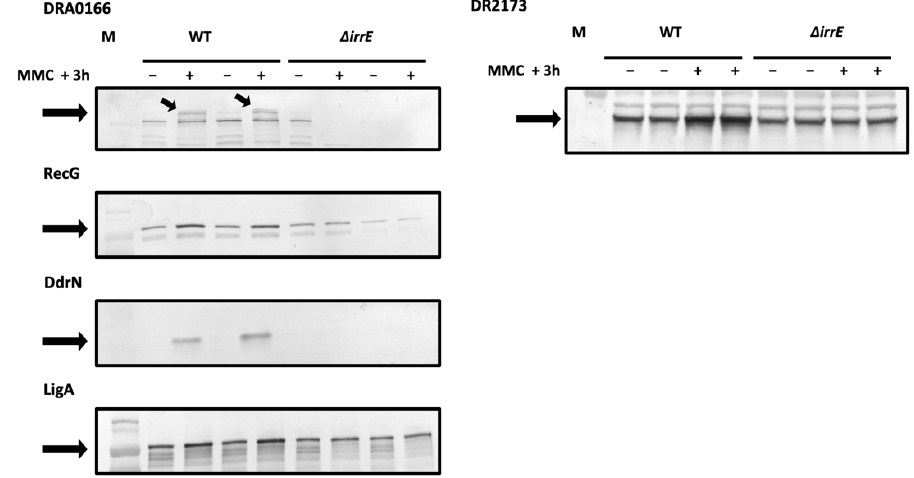
Figure 8. Expression of several new DdrO target genes induced after exposure to MMC in an IrrE and DdrO-dependent manner. ∆ irrE or wt cells expressing recombinant DRA0166-V5, RecG-V5, DdrN-V5, LigA-V5, and DR2173-V5 proteins were incubated (+) or not ( − ) with MMC (1 μ g/mL) at 30 °C for 3 h. Cell extracts were subjected to SDS-PAGE and analyzed by Western blotting with anti-V5 antibodies. For DRA0165 and DR2173, 15 μ g of proteins was loaded on each well, for RecG and DdrN, 10 μ g of proteins, and for LigA, 5 μ g.